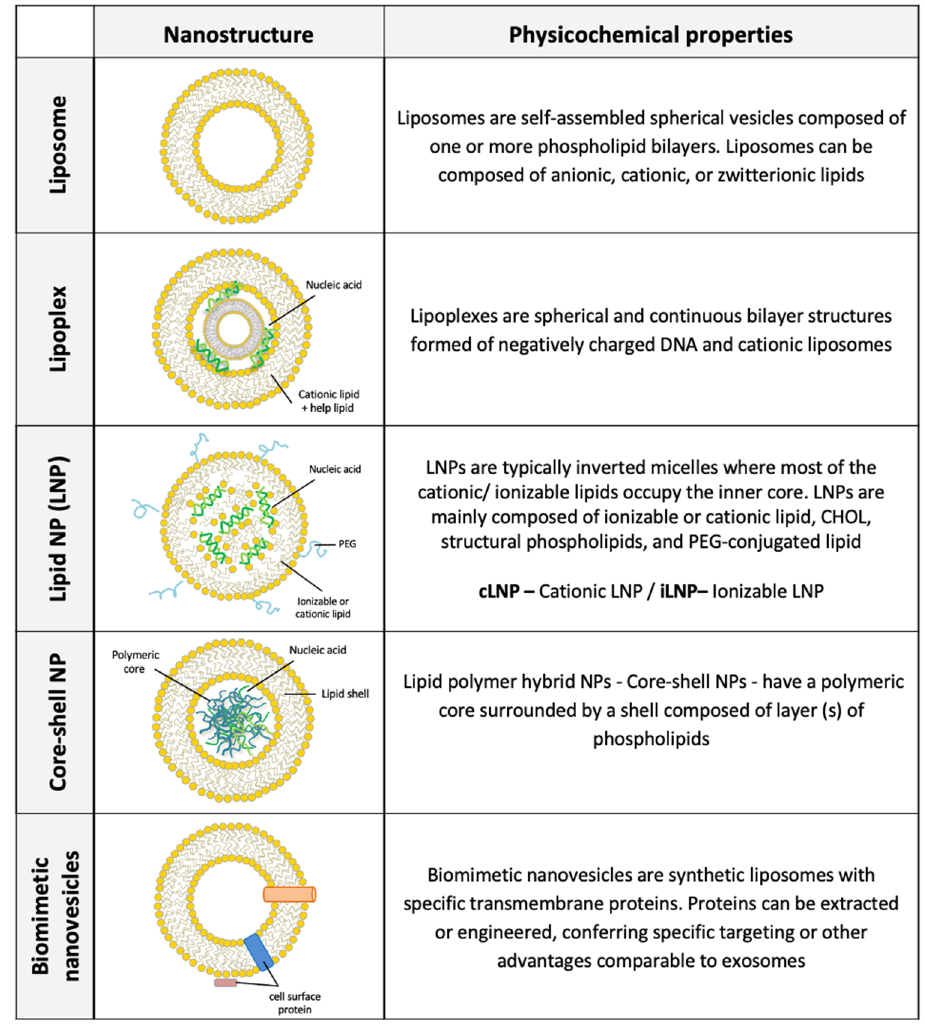
Figure 2. The main characteristics of lipid-based nanocarriers used for drug and gene delivery (liposomes, lipoplexes, lipid nanoparticles (LNP)—cLNP and iLNP—core-shell NP, and biomimetic nanovesicles). cLNP:LNP with cationic lipids (non-ionizable lipids) such as DOTAP. iLNP:LNP with a cationic source is the ionizable